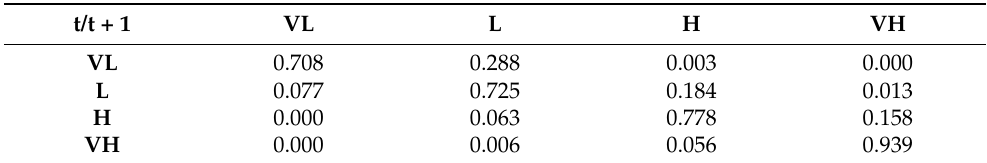
Table 2. Traditional Markov transfer probability matrix for the green development comprehensive level in YREB, 2008–2017.